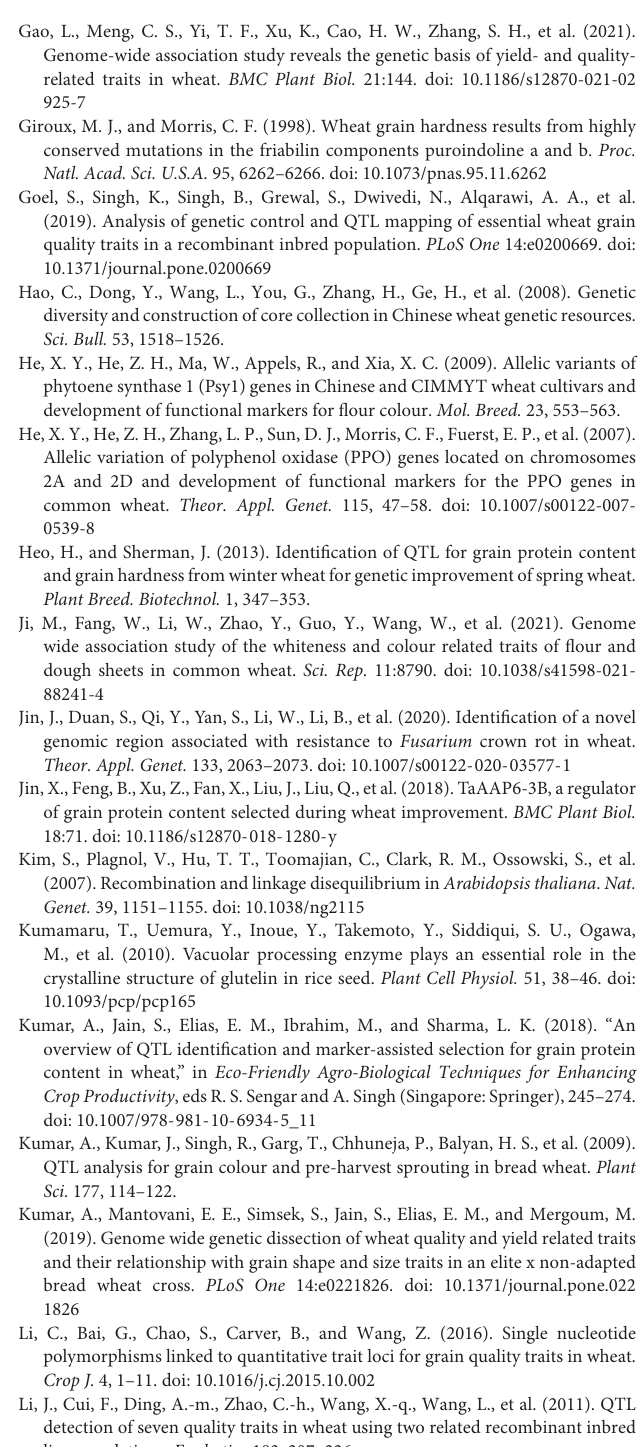
Supplementary Table 2 | Significant SNP for five quality traits in different environments identified by GWAS. Supplementary Table 3 | A total of 103 QTL composed of significant snp detected by